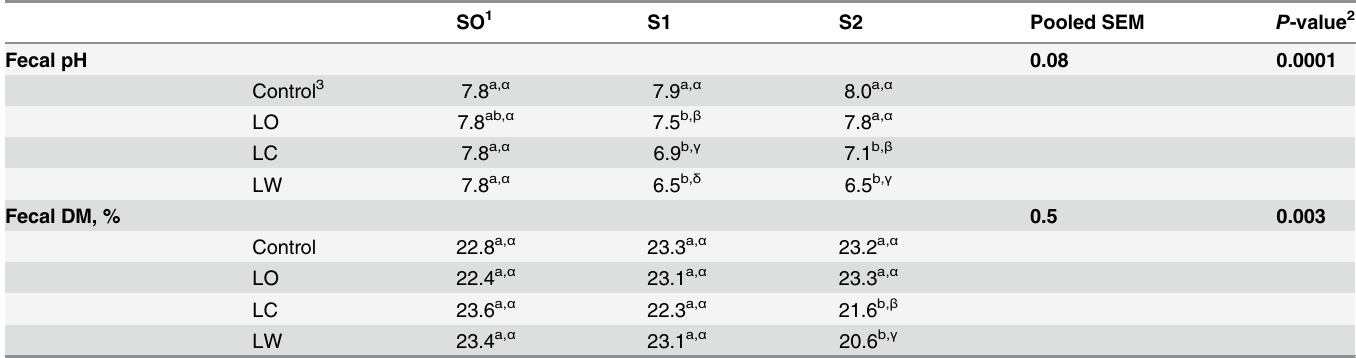
There was a treatment × sample day interaction for amylolytic bacteria enumerations with high starch intake ( P < 0.0001; Fig 1A). Amylolytic bacteria increased in both HC and HO horses, but the magnitude of this increase was starch source dependent. For S2, horses that received HO had 10-fold more amylolytic bacteria than horses fed hay only ( P < 0.05). In con- trast, horses fed HC had 100,000-fold more amylolytic bacteria than control horses for S2 Table 3. Effect of low oats, low corn and low wheat middling diets on fecal pH and DM. SO